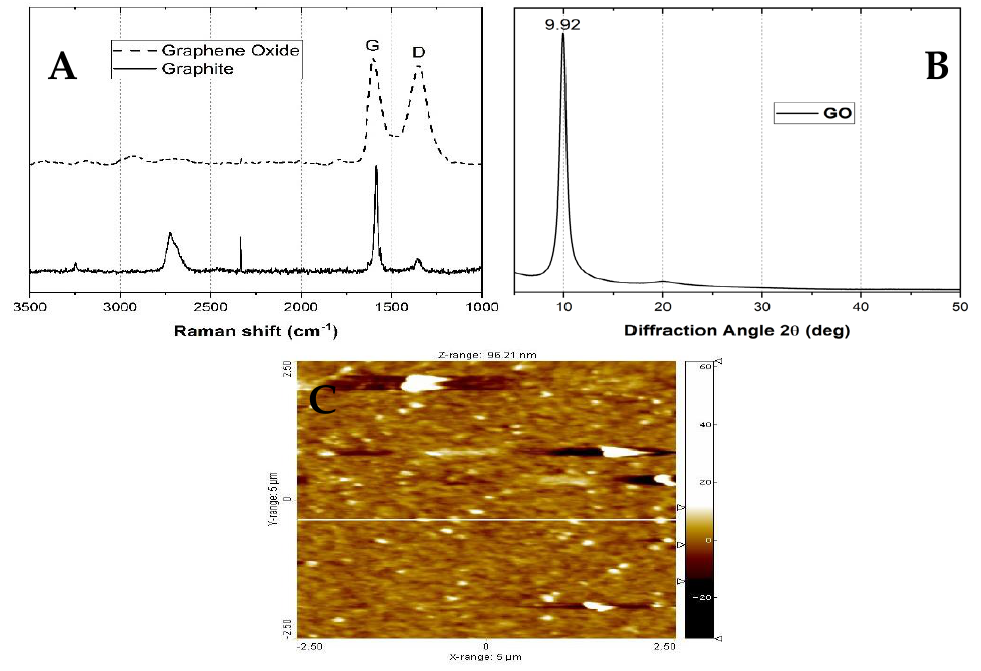
Figure 2. Characterization of GO by ( A ) Raman spectroscopy, ( B ) XRD, and ( C ) atomic force microscopy (AFM).